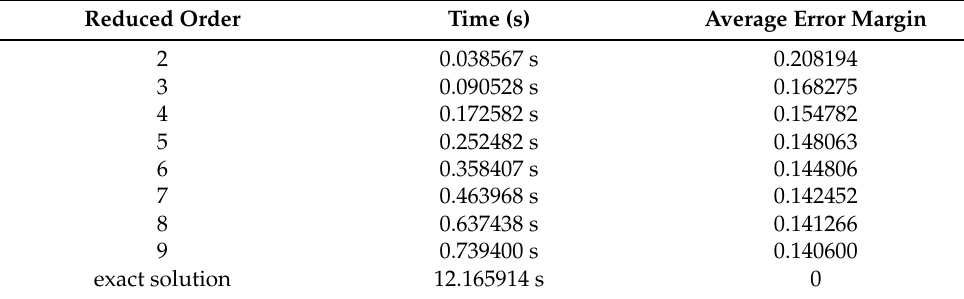
Table 1. The running time and margin of error in different orders.